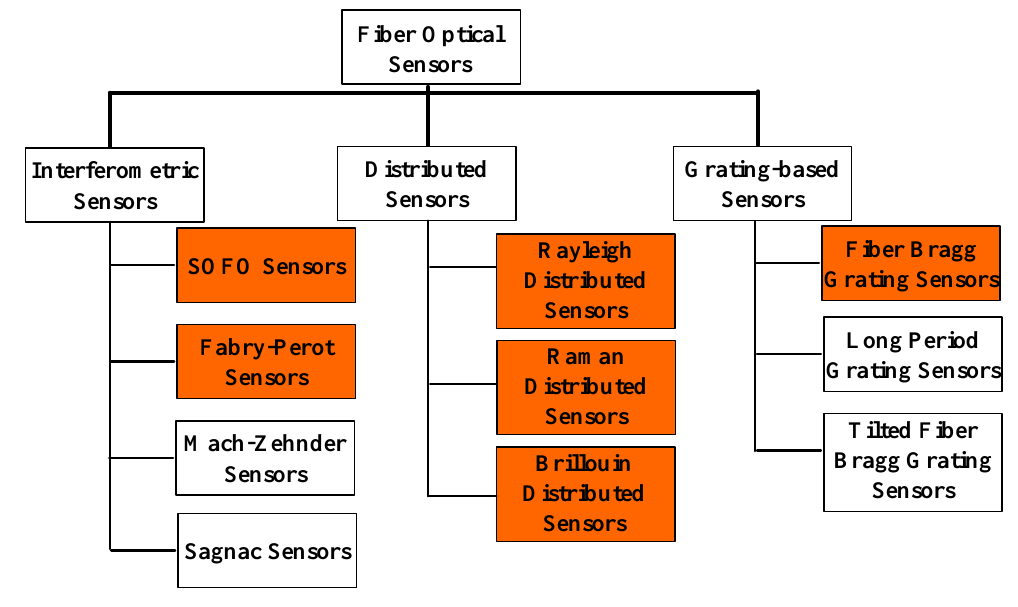
Figure 1. An overview of fiber optic sensor